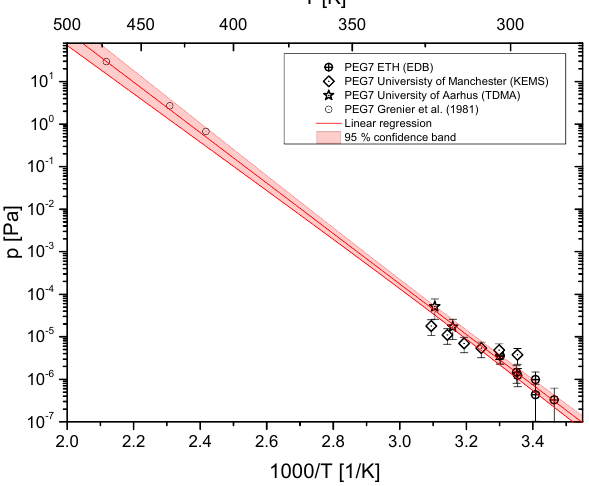
Figure 5. Saturation vapor pressures vs. temperature of hexaethy- lene glycol (PEG6). Symbols as in Fig. 2.